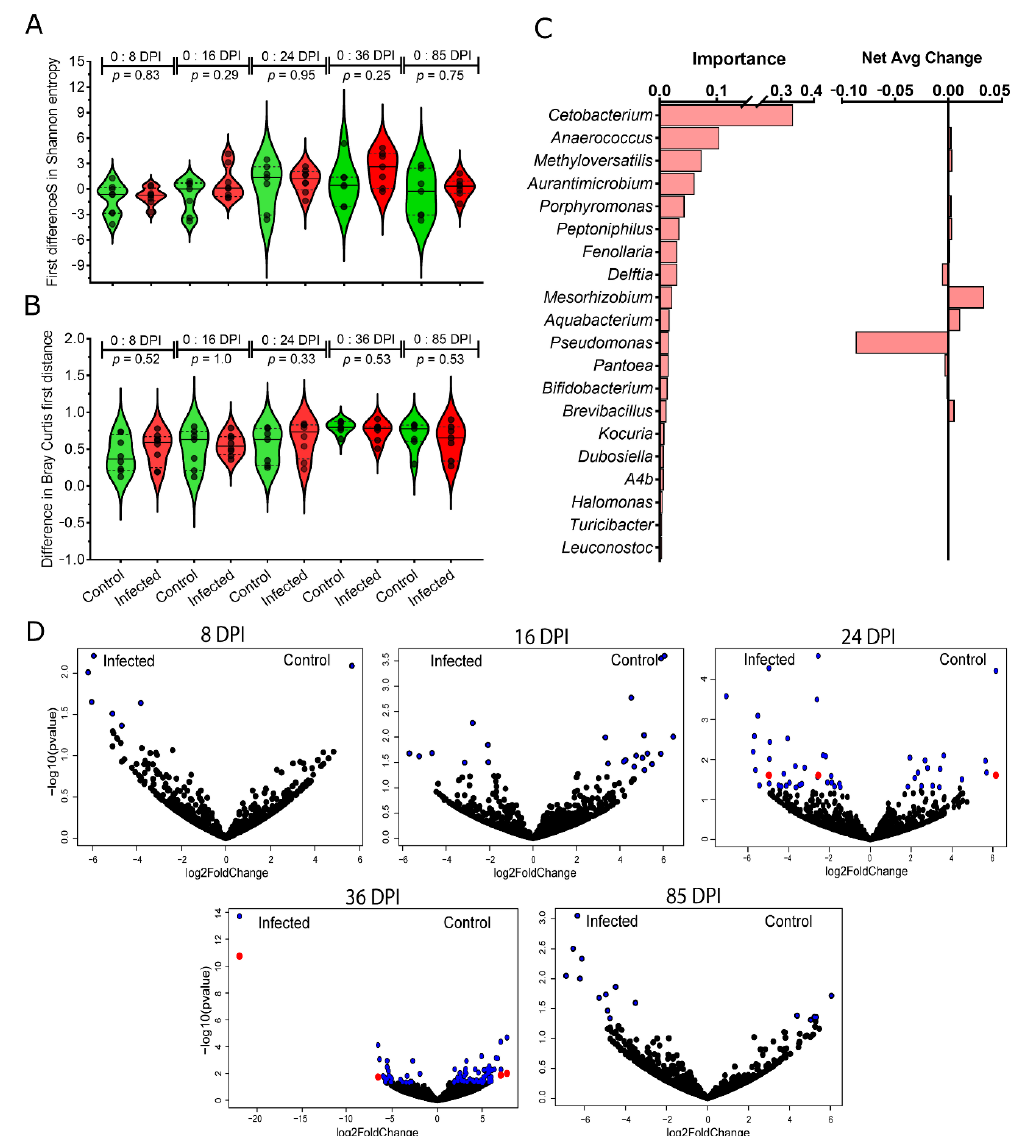
Figure 3. Effect of P. homocircumflexum infection on host microbial diversity and taxonomic profiles of bird microbiome. ( A ) Shannon entropy was used in the longitudinal analysis to compare the differences in alpha diversity between infected and uninfected birds at different time intervals (i.e., from 0 to 8 DPI, from 0 to 16 DPI, from 0 to 24 DPI, from 0 to 36 DPI, and from 0 to 85 DPI). Kruskal–Wallis was used to compare the differences (alpha = 0.05). ( B ) Similar longitudinal analysis was performed for beta diversity, based on Bray–Curtis distance. Between-groups comparisons were performed using Mann–Whitney U test (alpha = 0.05). ( C ) Longitudinal feature-volatility analysis of bacterial genera among infected and uninfected birds. The top 20 important features (i.e., from 100 taxa detected by random forest modeling exhibiting important temporal variations in abundance) are shown, including their temporal signal (importance) and net average change. ( D ) Volcano plot showing the differential bacterial abundance in bird microbiome between control and infected groups throughout the duration of experiment. Taxa with significant differences between the groups are represented with blue (Wald test, p < 0.05) and red (Wald test, p (corrected with Benjamin and Hochberg method) < 0.05) dots. The gray dots represent taxa with no significant differences between groups. Taxa with significant differences in their abundance were identified using DeSeq2